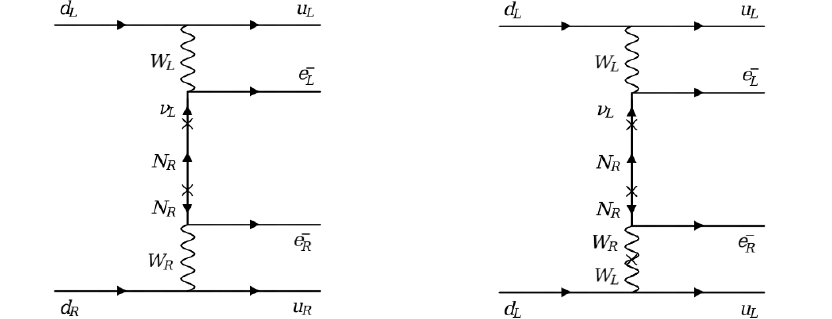
Figure 2 . Other possible contributions to 0 (cid:23)(cid:12)(cid:12) for which the (cid:12)nal electrons present opposite